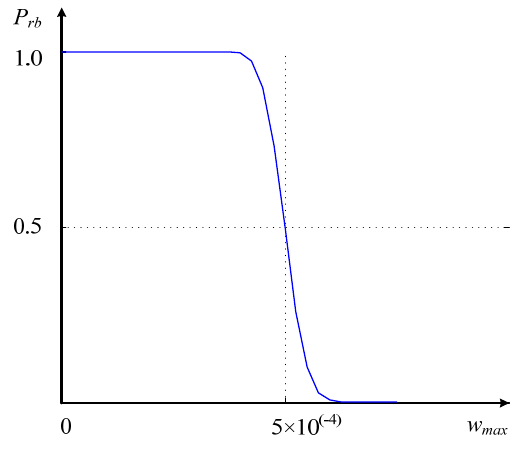
Figure 15. The relationship between the threshold and refuse-operation probability.